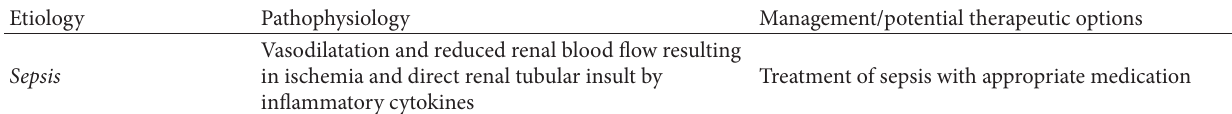
Table 3: Pathophysiology and management of AKI in